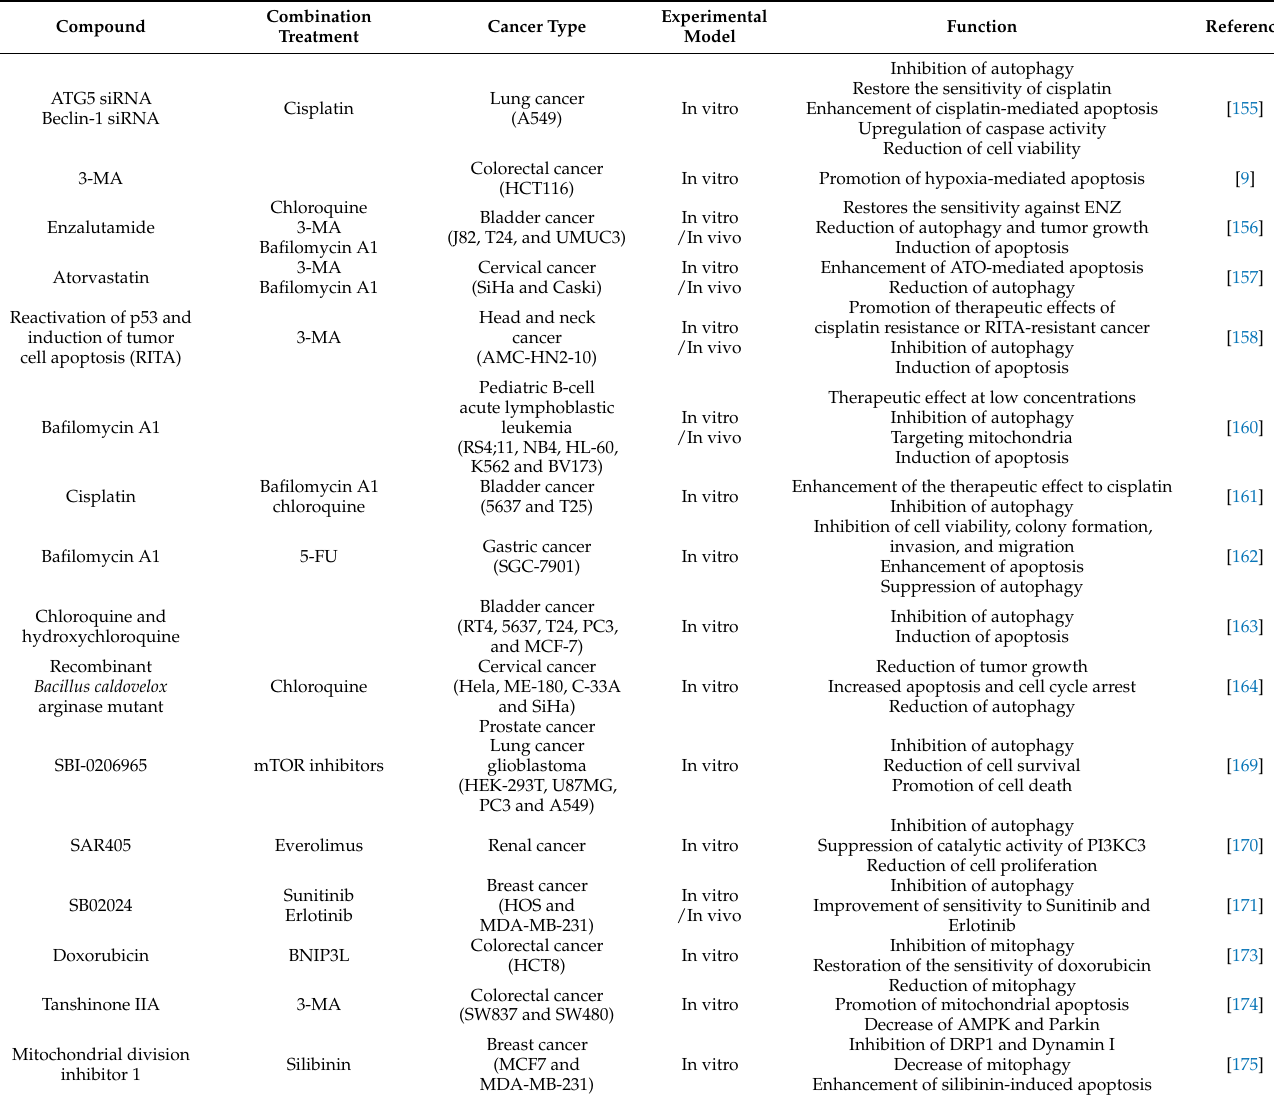
Table 1. The role of autophagy inhibitors in cancer